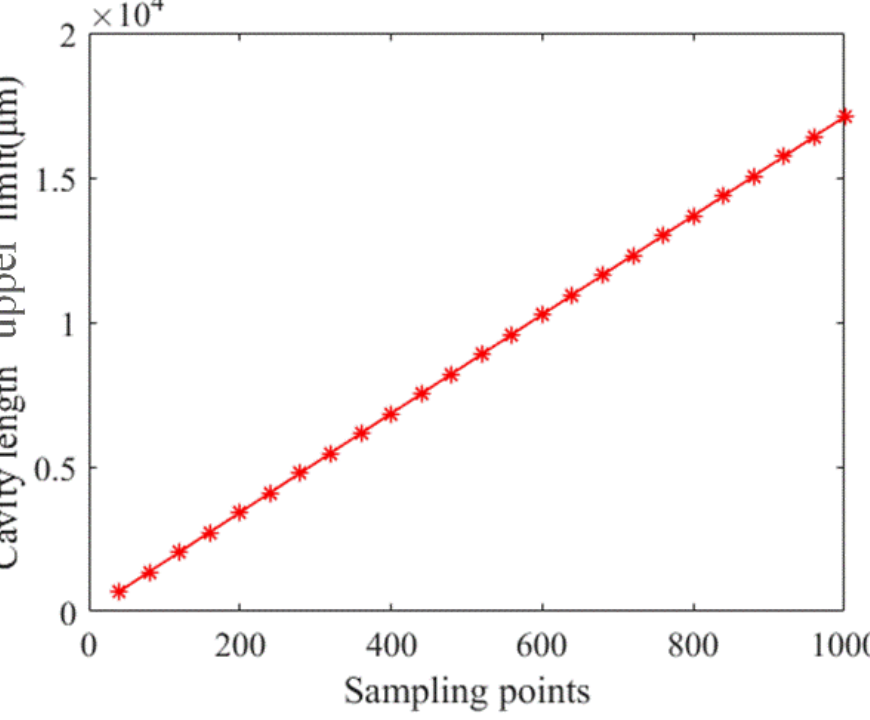
Figure 8. The relationship between the maximum EFPI cavity length and the number of sampling points.